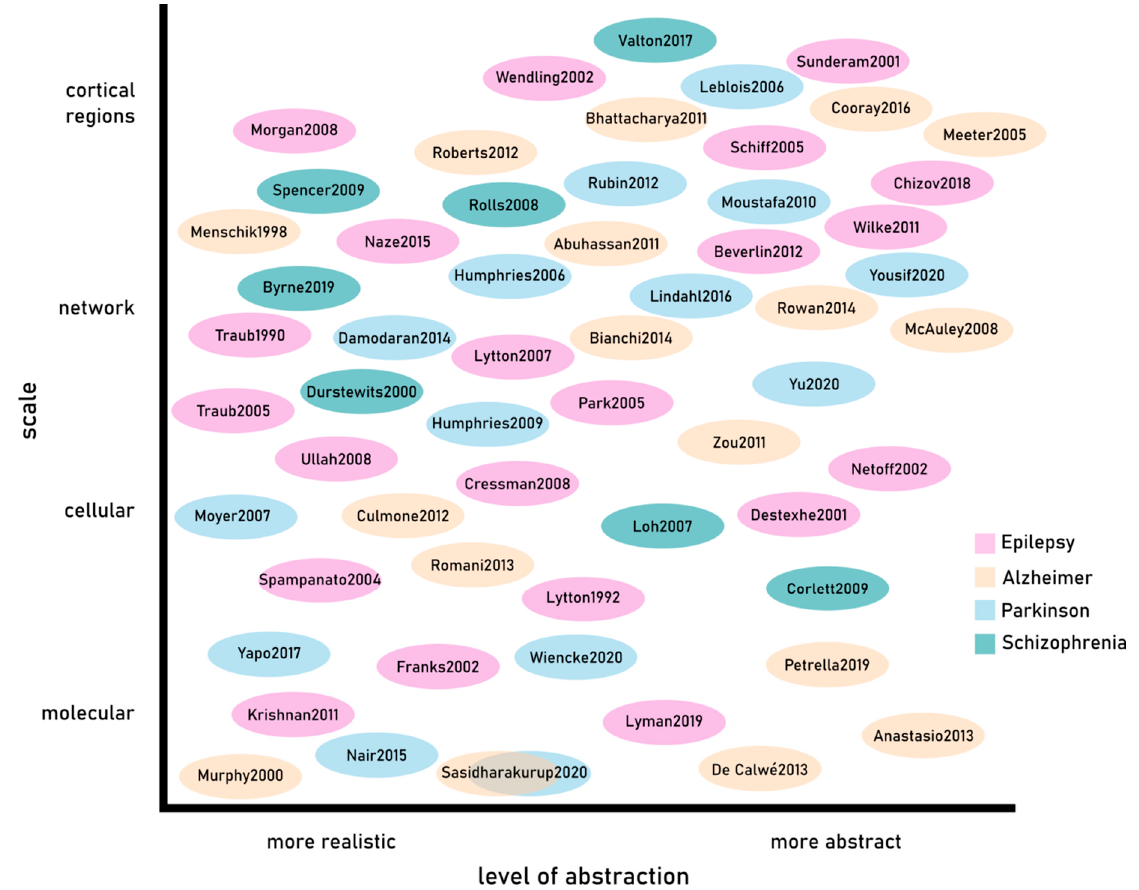
Figure 3. Computational models.